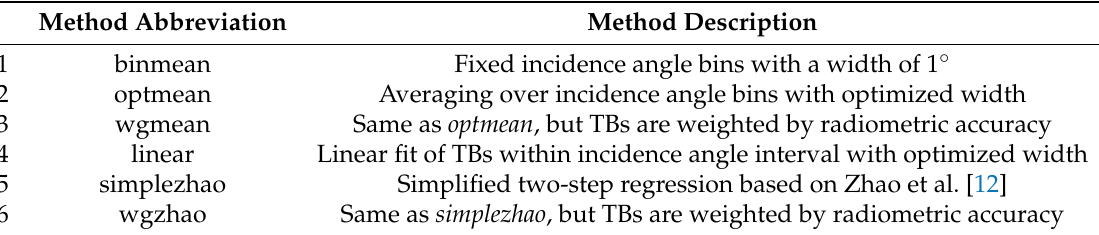
Table 1. Overview of the used fitting methods.